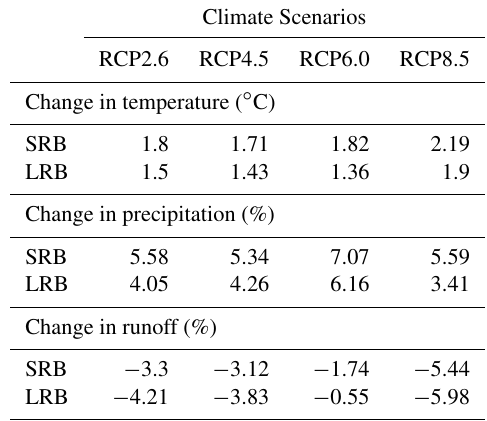
Table 1. Change in the average annual temperature, precipitation and runoff under alternative climate change scenarios from 2010 to